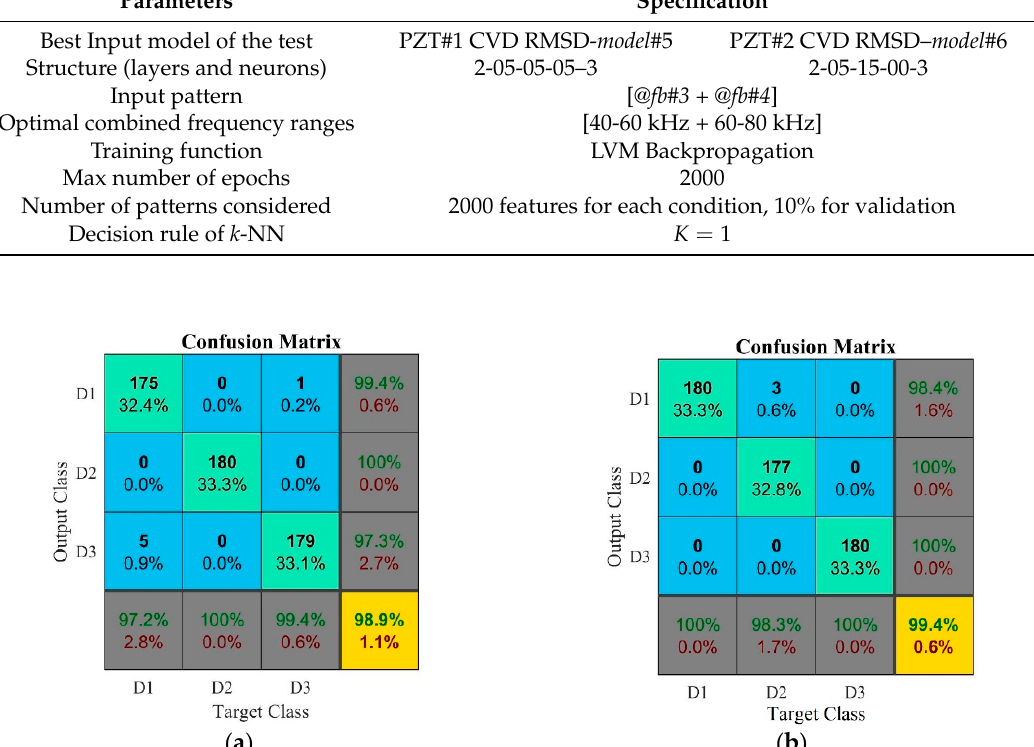
Figure 8. Confusion matrices of the best ANN models in experimental case #2: ( a ) model#5 ; and ( b ) model#7 .